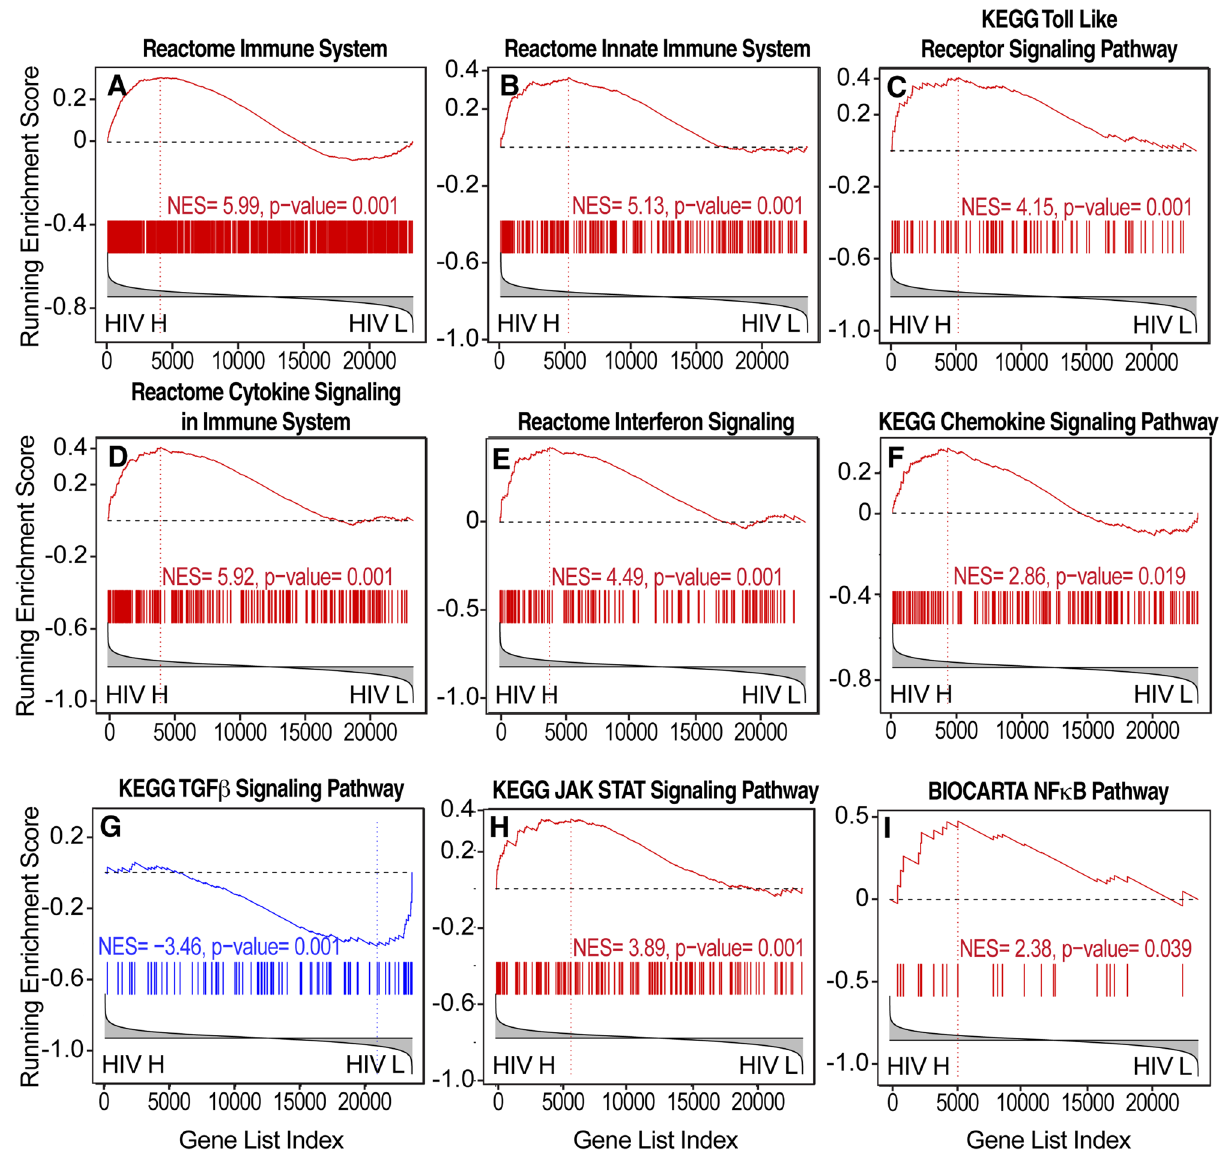
Figure 6. Evidence of increase in neuroinflammation correlated with brain HIV RNA load in white matter. ( A – C ) The pathway analysis by GSEA demonstrated broad immune activation and inflammation, characterized by increases in ( D ) cytokine, ( E ) interferon, and ( F ) chemokine signaling, ( G ) a decrease in transforming growth factor β (TGF-β) pathway signaling, ( H ) an increase in JAK STAT pathway signaling, and ( I ) an increase in nuclear factor κB (NFκB) pathway signaling. HIV H, high brain HIV RNA load; HIV L, low brain HIV RNA